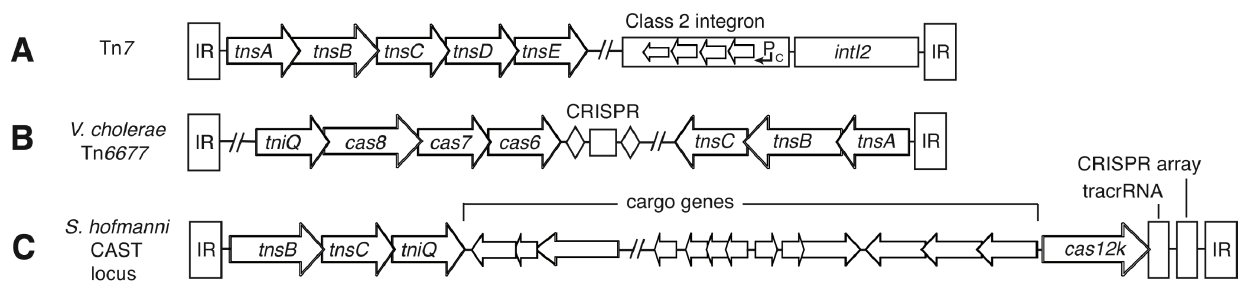
Figure 2. Sequence structure of the Tn 7 transposon and derivatives encompassing clustered regularly interspaced palindromic repeats (CRISPR)–Cas-type systems. A ) The structure of a typical Tn 7 transposon is shown, with terminal inverted repeats (IR) shown as boxes and constituent genes shown as arrows. The diagram is based on the structure of the Escherichia coli R721 shufflon. B ) The structure of the Vibrio cholerae Tn 6677 transposon is shown. Tn 7 -derived elements and the CRISPR array are indicated. C ) A representation of the Scytonema hofmanni CAST locus is provided, encompassing Tn 7 -like open reading frames, the effector Cas12k, and the CRISPR array. The loci are not drawn to